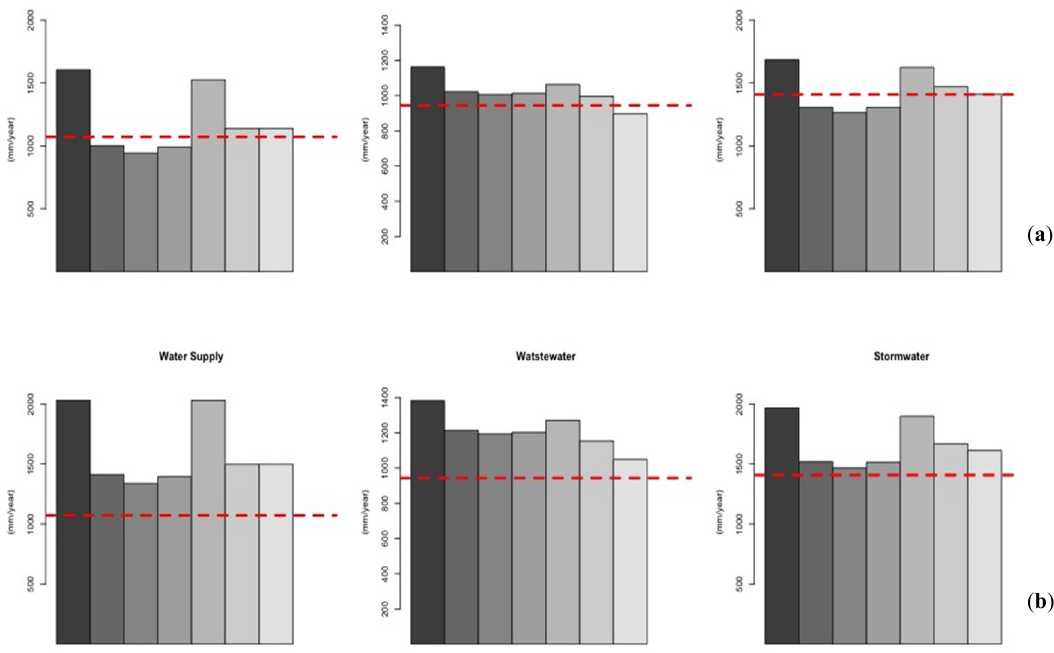
Figure 3. ( a ) Flow of Drinking Water, Wastewater, and Stormwater for the 10 ‐ year period and ( b ) Flow of Drinking Water, Wastewater, and Stormwater for the 20 ‐ year future cases in Fucha Catchment.